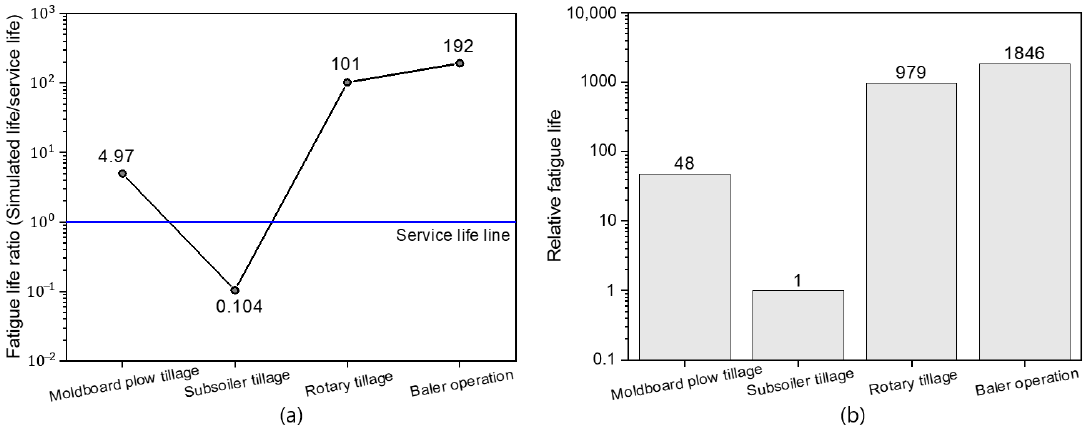
Figure 10. Fatigue life evaluation for major agricultural operations: ( a ) fatigue life ratio based on service life and ( b ) relative fatigue life based on subsoiler tillage.